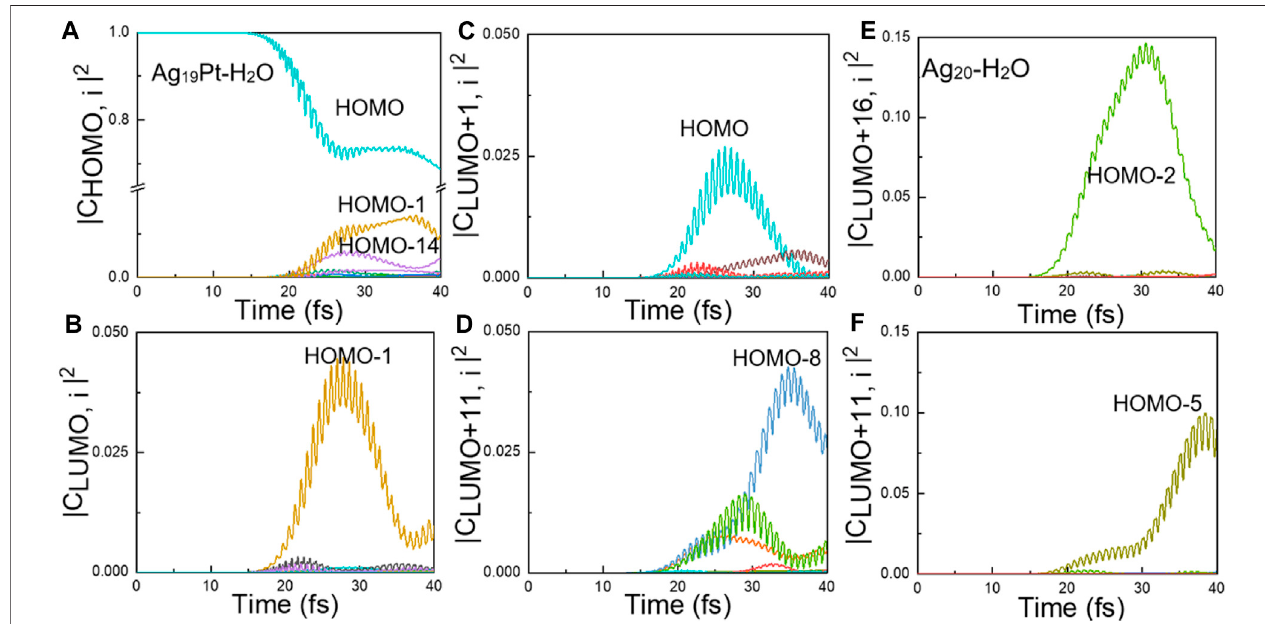
FIGURE 5 | Ultrafast electron dynamics. Time-evolved transition coef fi cients from all the occupied states i to the Kohn – Sham state of (A) HOMO, (B) LUMO, (C) LUMO+1, and (D) LUMO+11 for Ag 19 Pt – H 2 O, respectively. The index i ( i (cid:1) 0 – 18) denotes the numerical order of the occupied states, while LUMO + j ( j (cid:1) 0 – 19) corresponds to the unoccupied states. Time-evolved transition coef fi cients from all the occupied states i to the state (E) LUMO+11 and (F) LUMO+16 for Ag 20 – H 2 O, respectively. The index i ( i (cid:1) 0 – 13) denotes the numerical order of the occupied states, while LUMO + j ( j (cid:1) 0 – 19) corresponds to the unoccupied states. Only the important orbitals that signi fi cantly contribute to the density change are